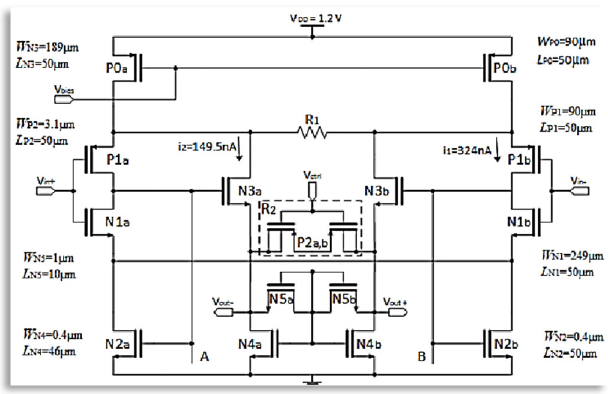
Figure 6. Schematic of the LPLNA introduced in [26].